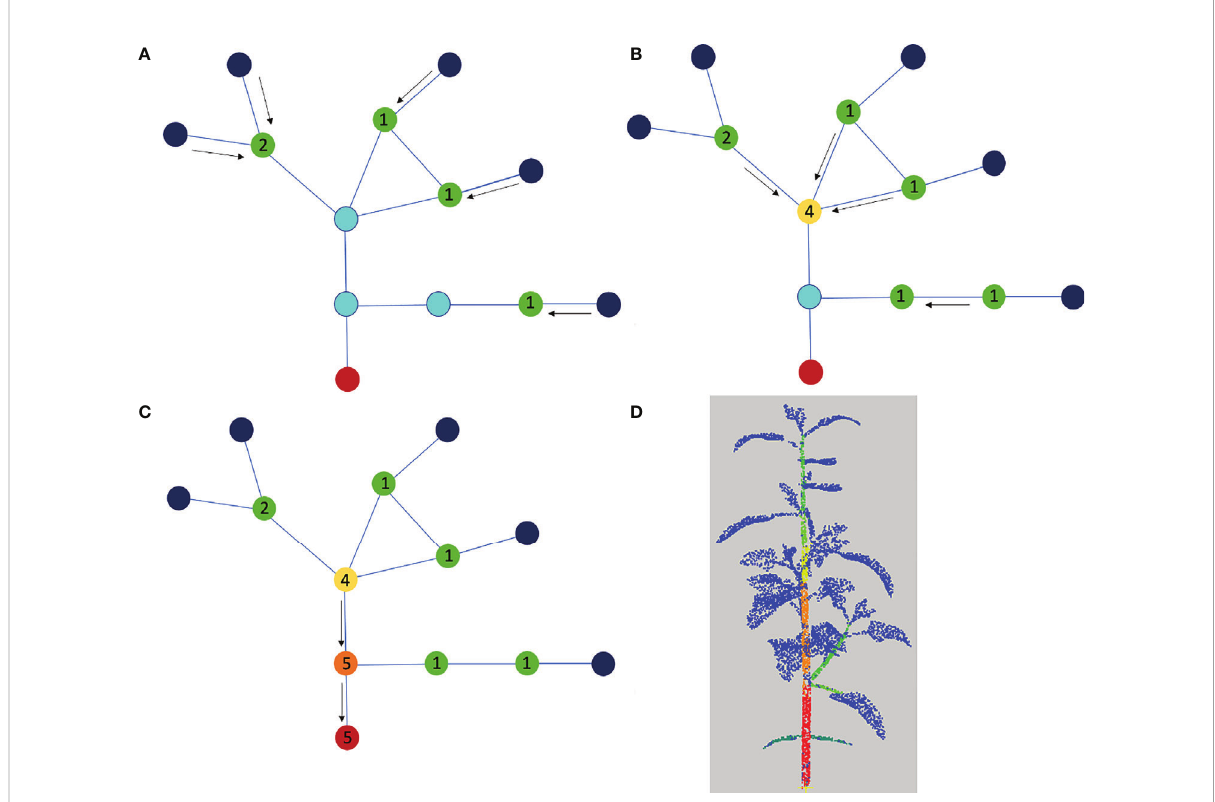
FIGURE 6 Determination of the main stem using the quotient graph. The root node corresponding to the main stem is shown in red, the nodes representing linear organs are in light blue and the apex or leaf blade nodes are in dark blue. (A-C) We compute the shortest paths from each leaf blade or apex node to the root node and add one unit load to each blue node on each path. At the end of the process, the load on each blue node corresponds to the number of shortest paths it belongs to. (D) Segmentation color-coded with the loads, from blue (0) to red (3). The blue is associated with the leaf blades and